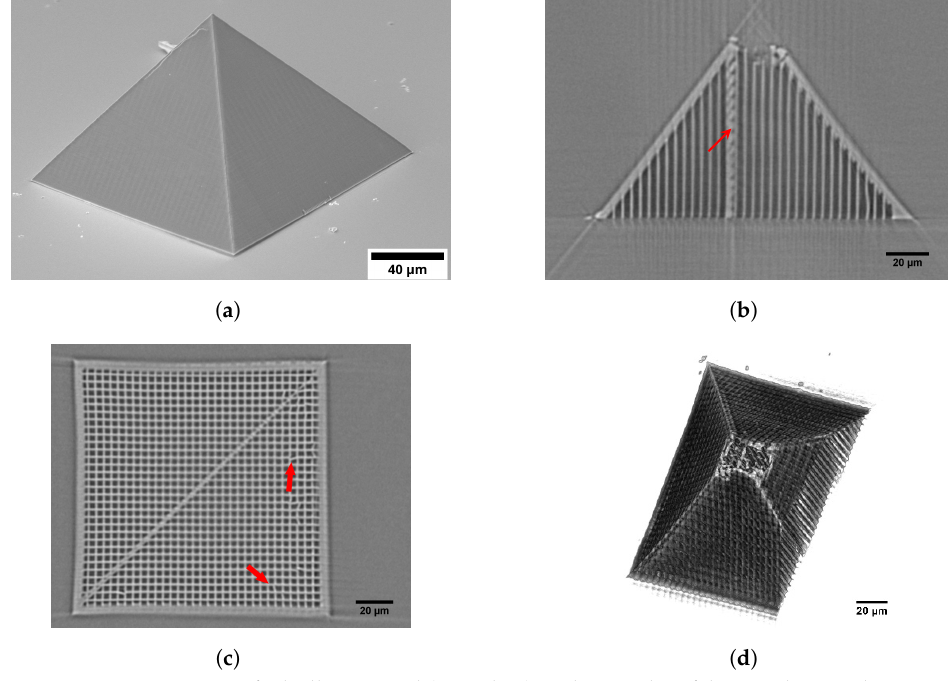
Figure 8. A SEM image of a bulk pyramid (sample 2) with complete fabricated tip is shown in ( a ). XCT images of a sample 2 variant with missing tip is shown in: ( b ) horizontal (X-plane) and ( c ) vertical (Z-plane) XCT view with highlighted defects (red arrows), and ( d ) as a 3D rendering